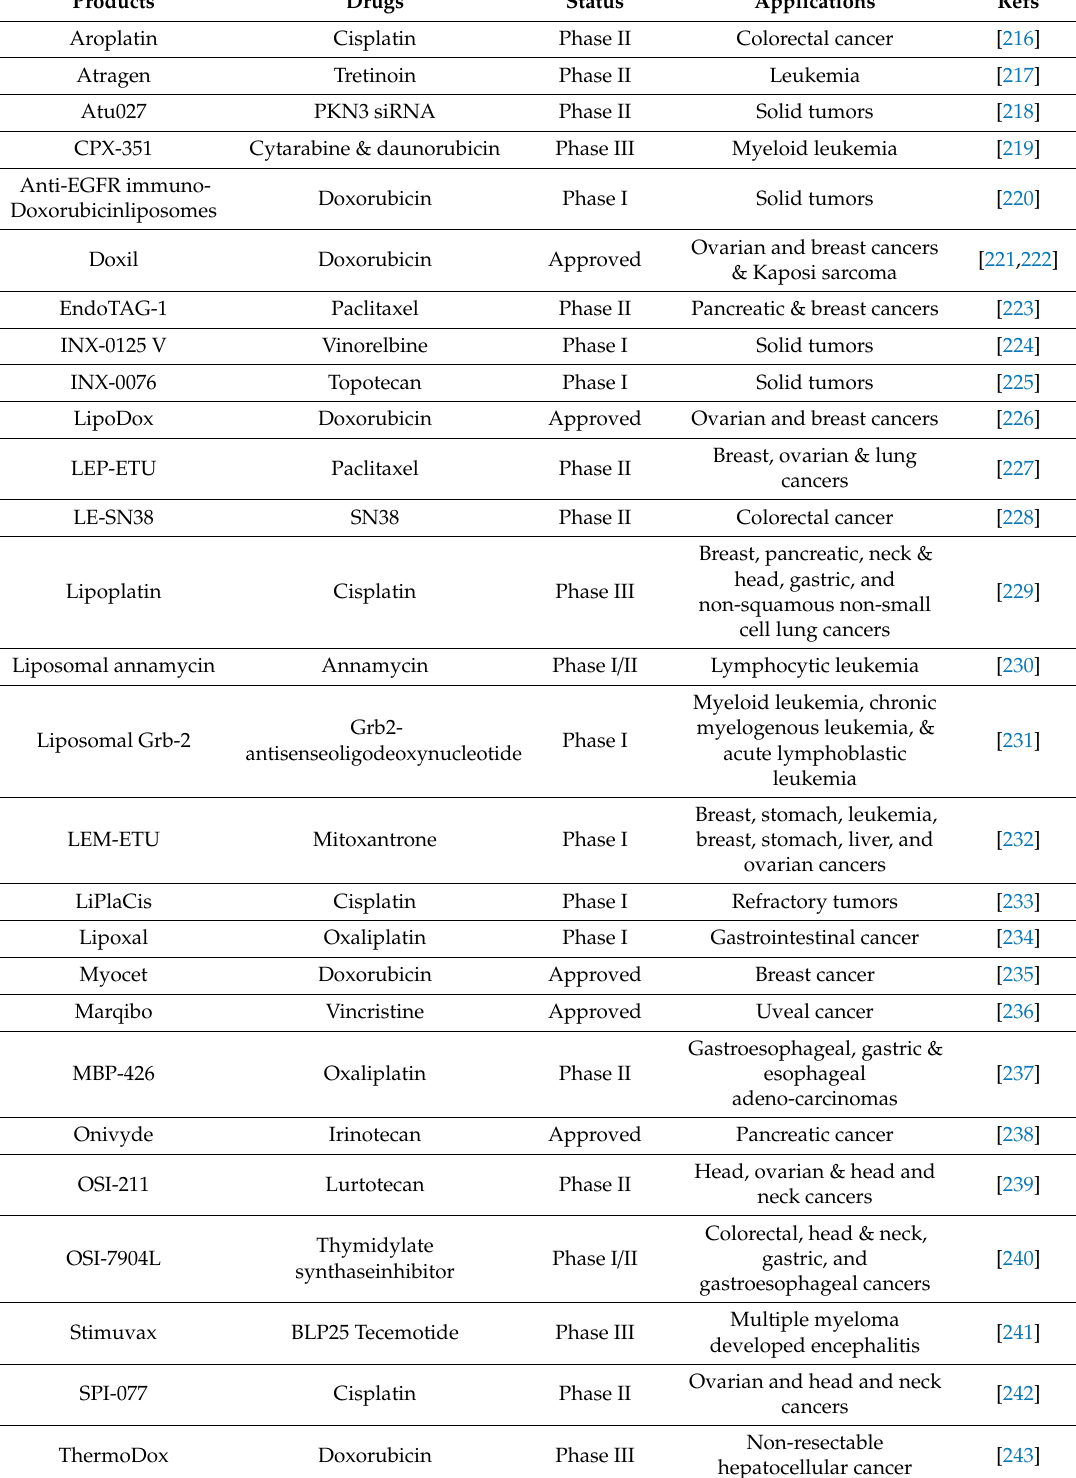
Table 6. The liposomal NPs based drugs in clinical